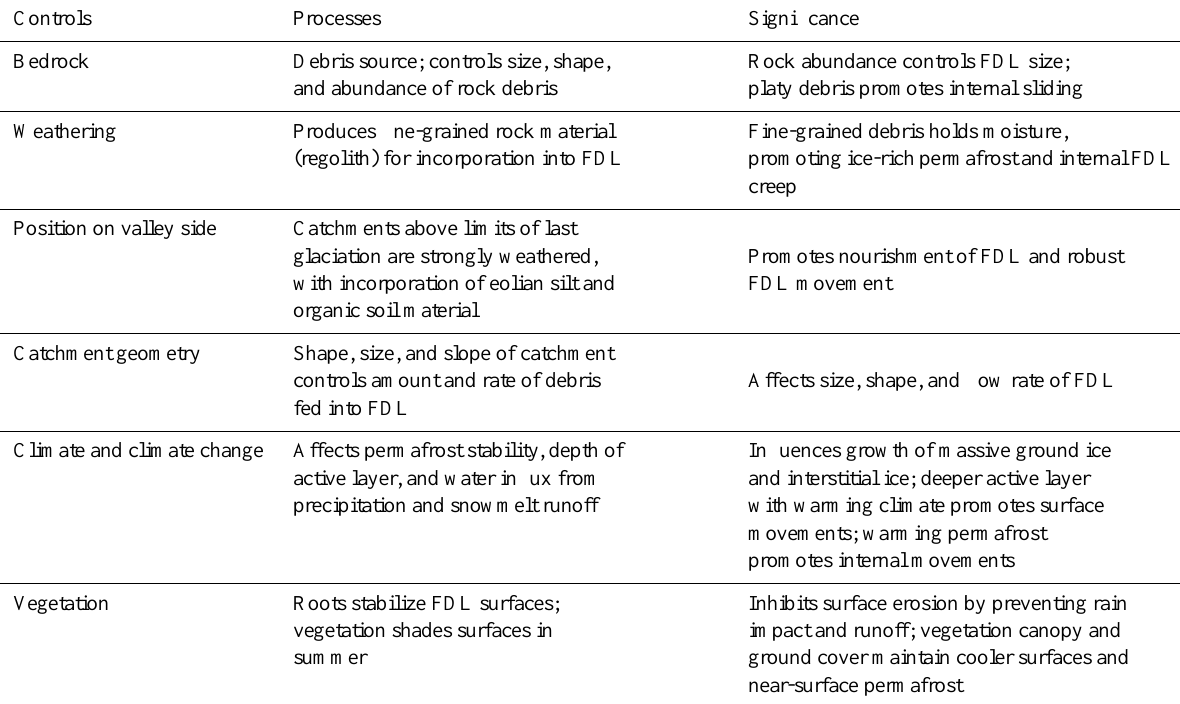
Table 2. Controls on frozen debris-lobe(FDL)